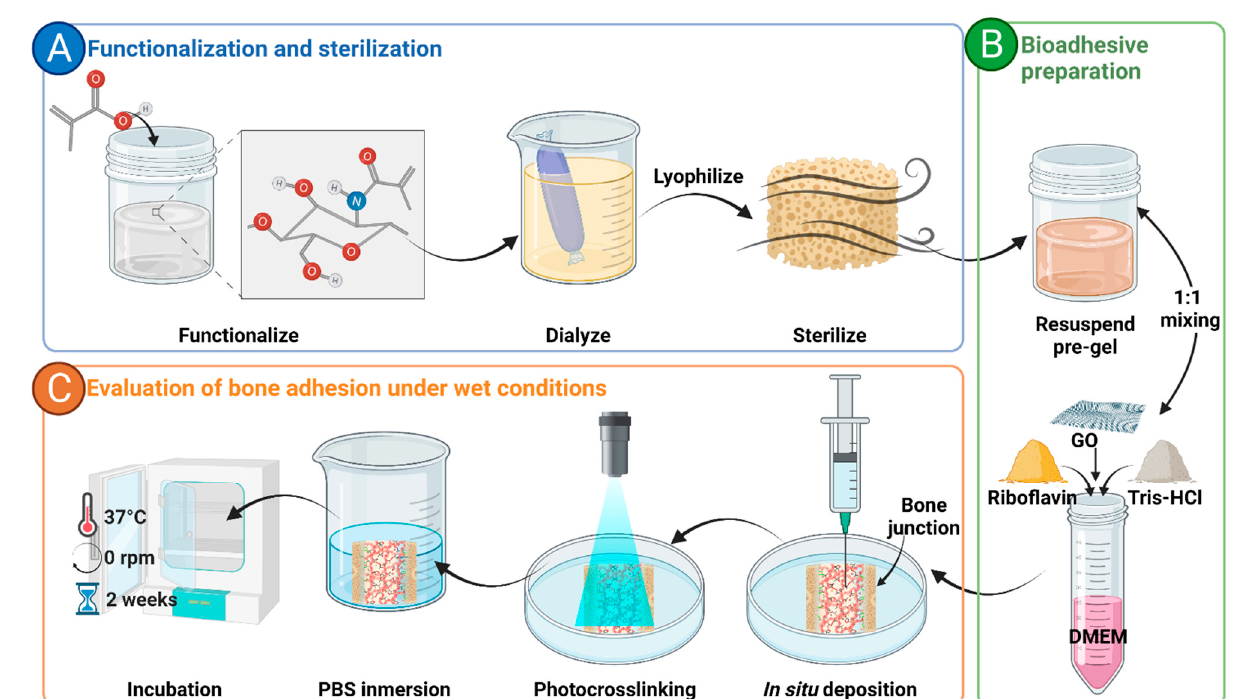
Figure 3. General methodology employed for the development of the bioadhesive. ( A ) Functionalization and sterilization of chitosan methacrylate (ChiMA). ( B ) Preparation of the bioadhesive with graphene oxide (GO) and riboflavin. ( C ) Eval- uation of the adhesive potential under wet